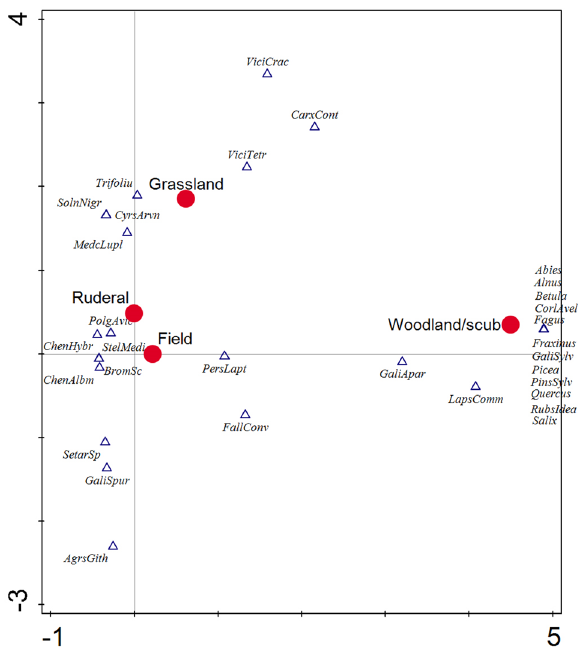
Figure 9. Hvožďany: detrended correspondence analysis (DCA) Displayed samples and botanical taxa: the first axis explains 64.08% variability, the first and the second axis together 72.12%.